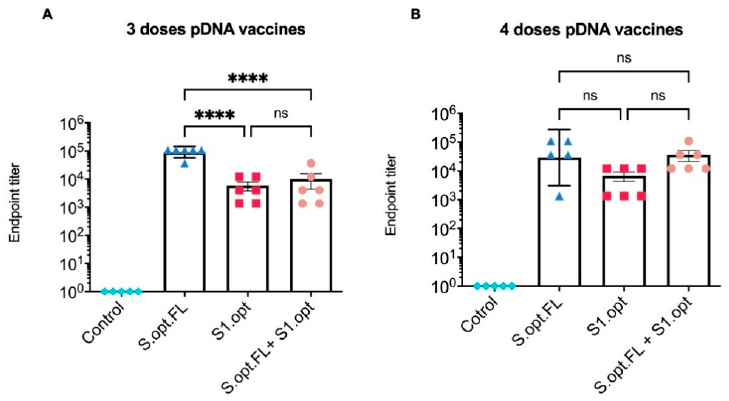
Figure 4. Serum endpoint immunoglobulin G (IgG) ELISA titers against autologous full-length spike (S) protein. ( A ). Total IgG S antibodies were measured in mice sera 2 weeks after the third